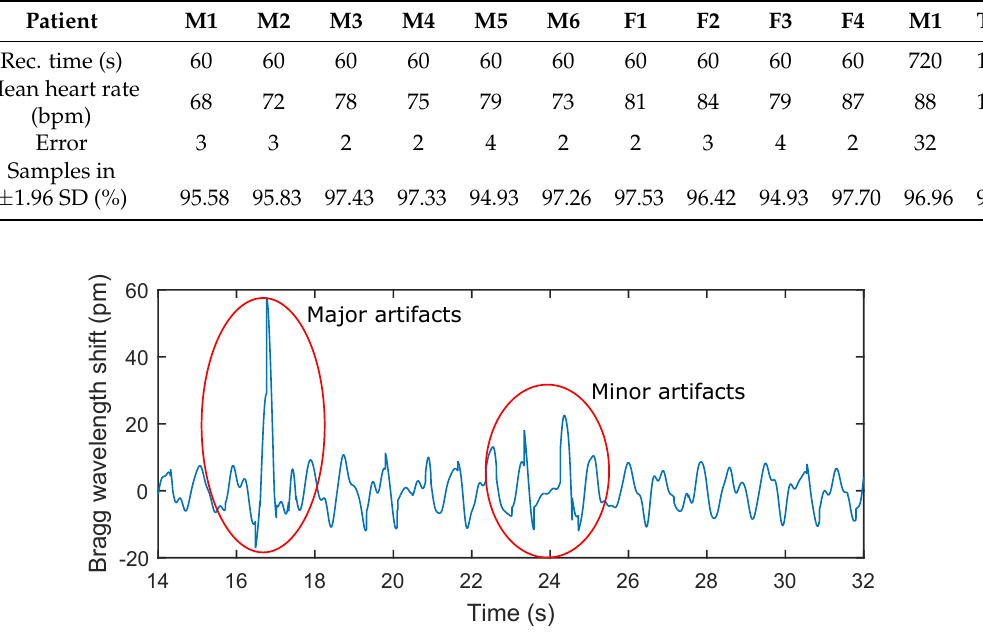
Table 3. Summary of the experimental results of heart rate measurements for six men (M1–M6) and four women (F1–F4).